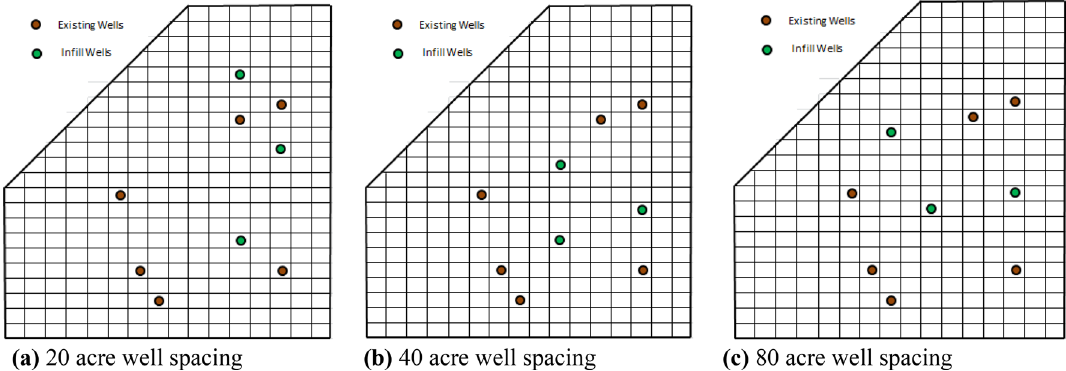
Fig. 8 Optimized locations for 3 vertical infill wells at different well spacings. Existing wells are indicated by brown color and infill wells indi- cated by green